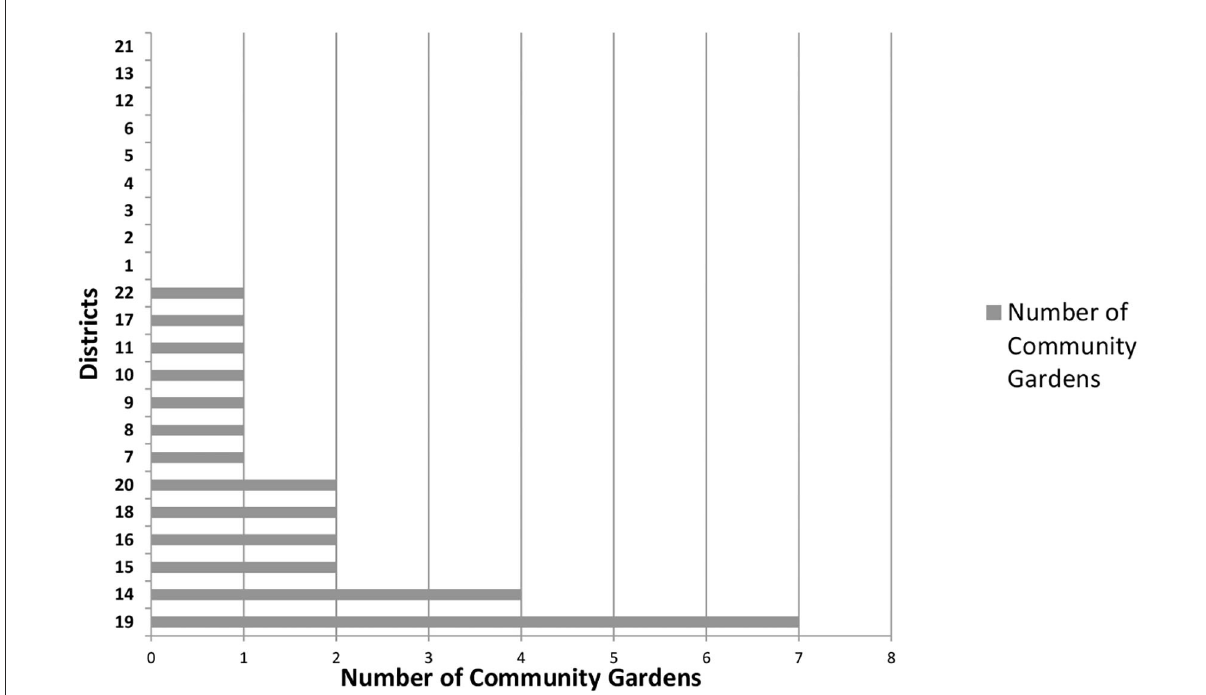
FIGURE4 Total number of present community gardens in each